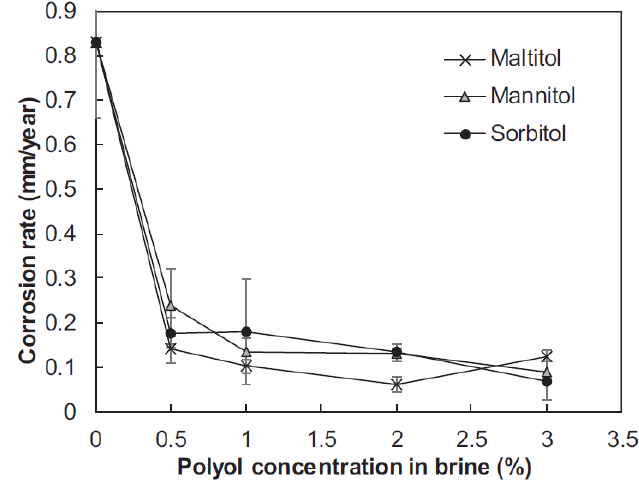
Figure 2. ASTM A572 corrosion rate versus polyol concentration in de-icing solution. Reprinted with permission from [7].